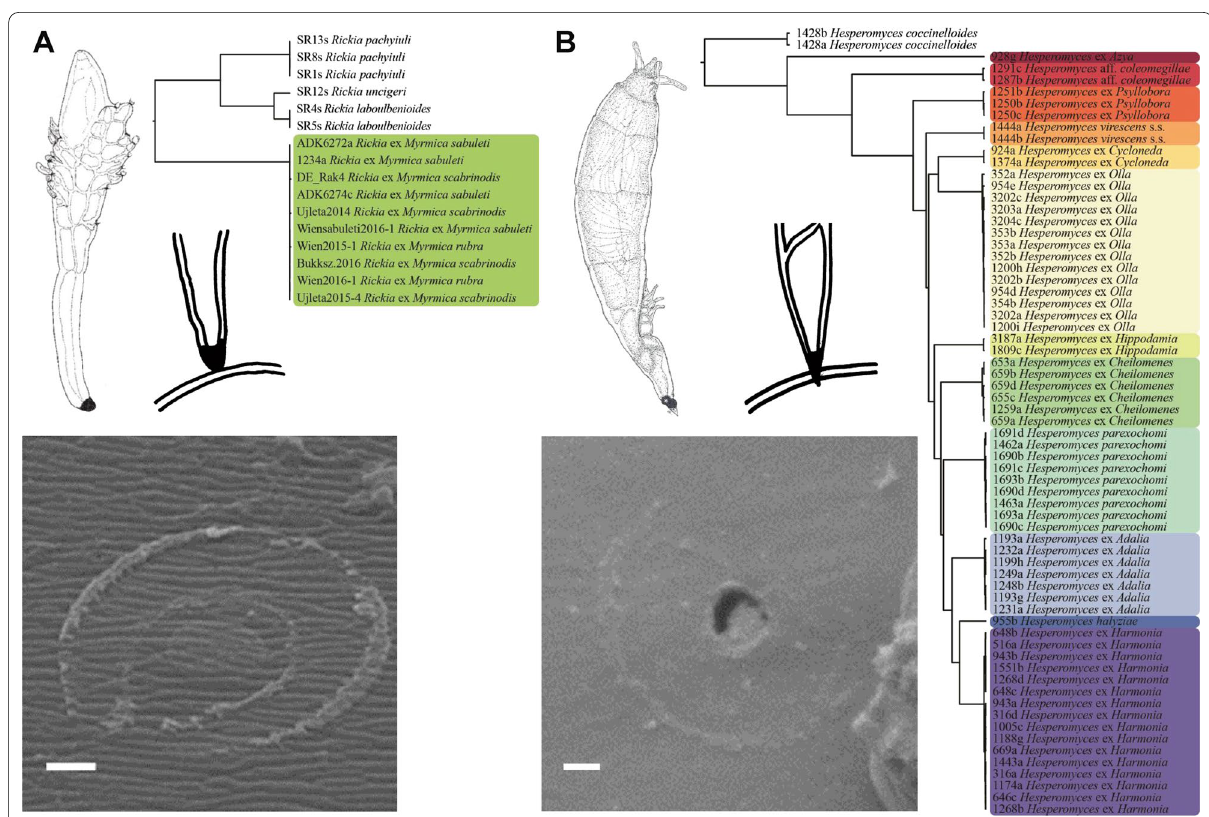
Fig. 1 Visualization of the proposed One-Host-One-Parasite model. A . Rickia wasmannii , a single phylogenetic species with Myrmica hosts in phylogenetically unrelated species groups; no penetration through the host’s integument into the haemocoel; and a horseshoe-shaped imprint around a circular inner ring at the otherwise unaffected host integument (scanning electron micrograph, from J. Billen, X. Espadaler, A. Tartally, and S. Tragust). B . Hesperomyces virescens , a complex of multiple species, each species corresponding to a phylogenetic clade with isolates from thalli removed from a given host; penetration through the integument; and a circular 1-µm diameter penetration pore (scanning electron micrograph, from M. Lubbers). Bars 1 µm. Color schemes for monophyletic clades from https:// color brewe r2. org by C.A. Brewer, Geography, Pennsylvania State =